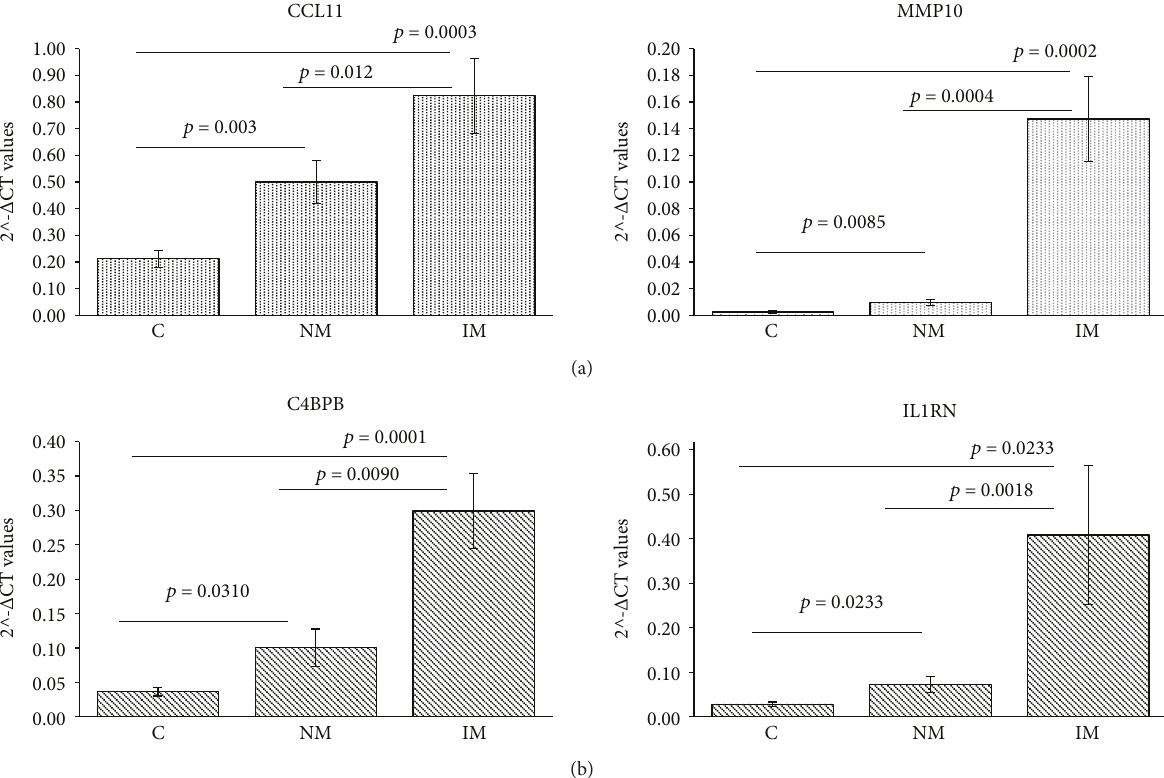
Figure 2: Bar graphs represent the mean of the 2 ^ - Δ CT values, and error bars represent the standard error. The graphs show the genes di ff erentially expressed comparing in fl amed mucosa (IM) vs. nonin fl amed mucosa (NM) IM vs. NM (paired), IM vs. C, and NM vs. C in UC (a) and in CD (b). C =non-IBD controls; IM =in fl amed mucosa; NM=nonin fl amed